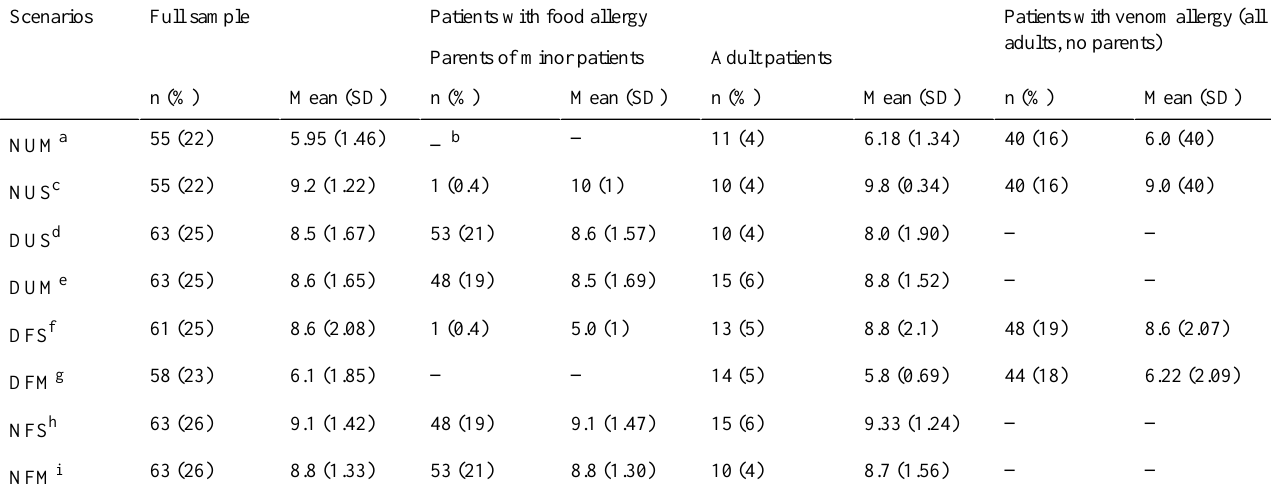
Table 5. Mean levels of willingness to respond, for each assigned scenario across survey populations.